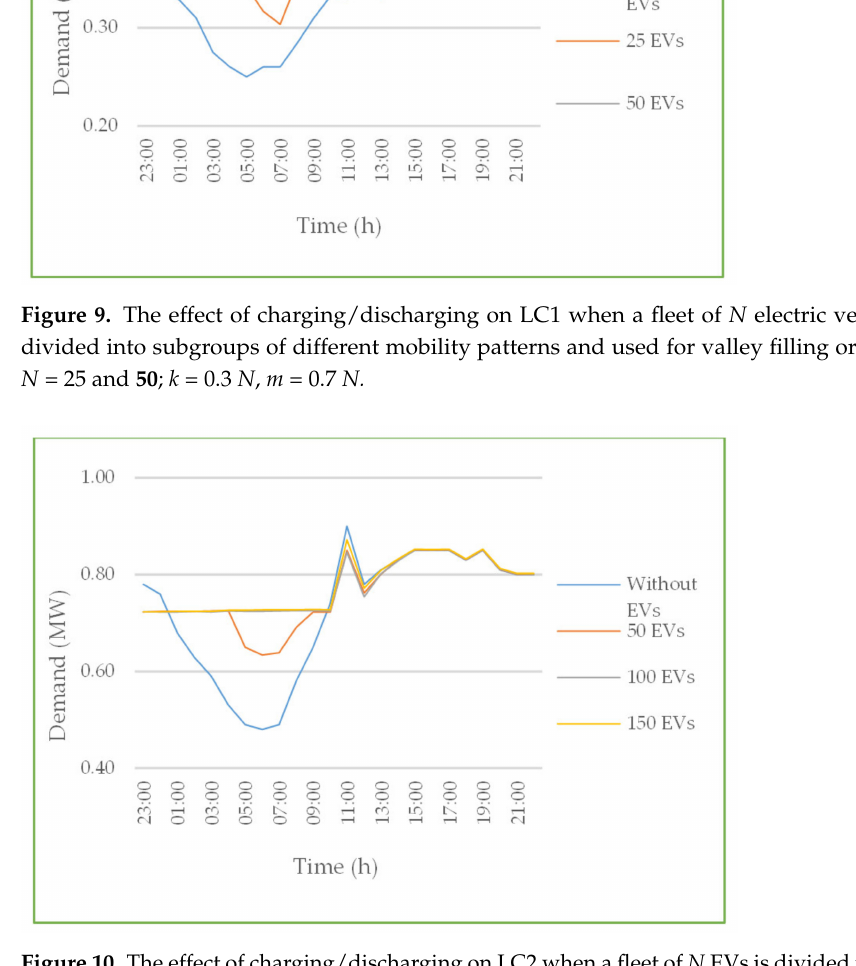
Figure 10. The effect of charging/discharging on LC2 when a fleet of N EVs is divided into subgroups of different mobility patterns and used for valley filling or peak shaving: N = 50 and 100 , 150; k = 0.3 N , m = 0.7